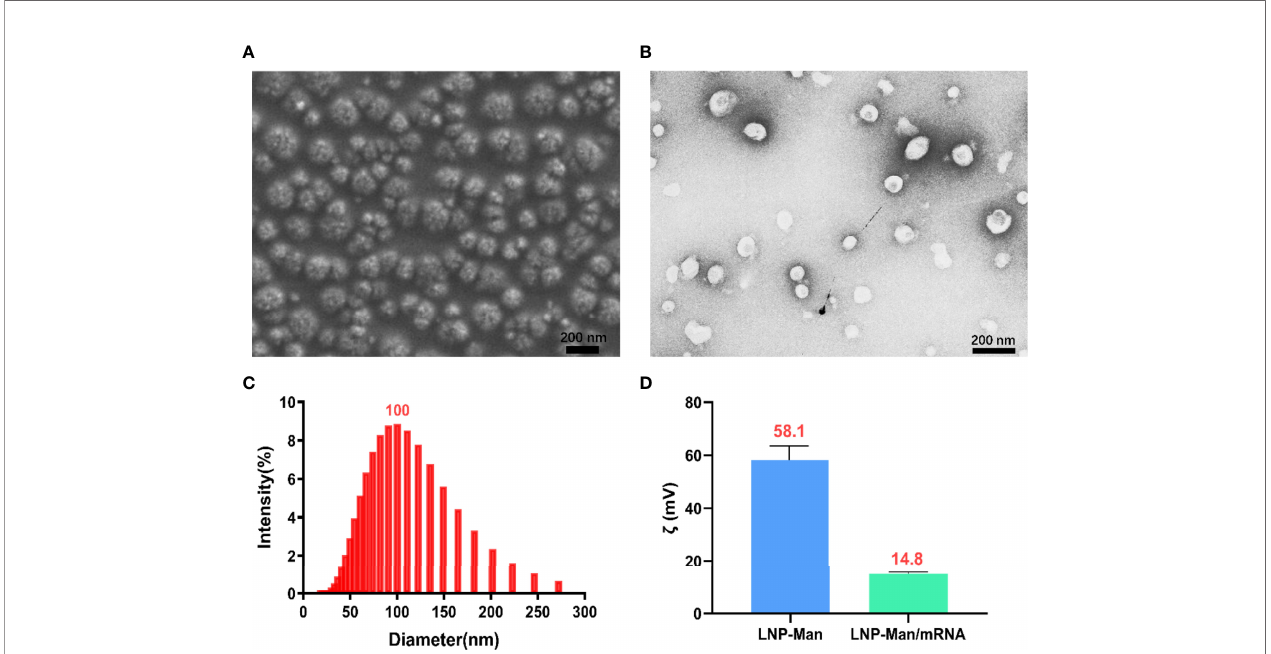
FIGURE 2 | Characterization of LNP-Man/mRNA. (A) Scanning electron microscopy (SEM) and (B) transmission electron microscopy (TEM) images of LNP-Man mixed with mRNAs, as well as (C) particle diameter distribution diagram. (D) Zeta potential values of LNP-Man mixed with mRNA before and after. Data were shown as mean ± SDs (n =